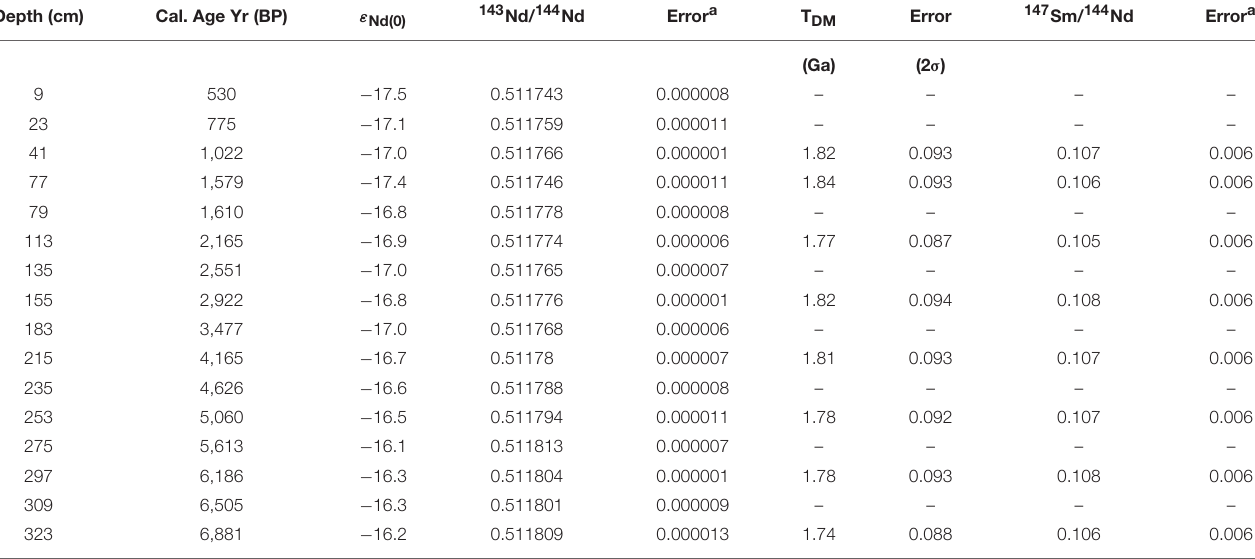
TABLE 2 | Nd systematics isotopic data of the Core 7620. Depth